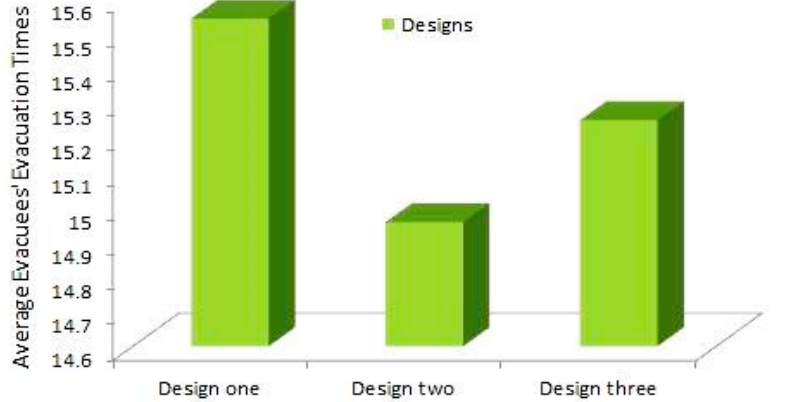
ff erent designs of the evacuation